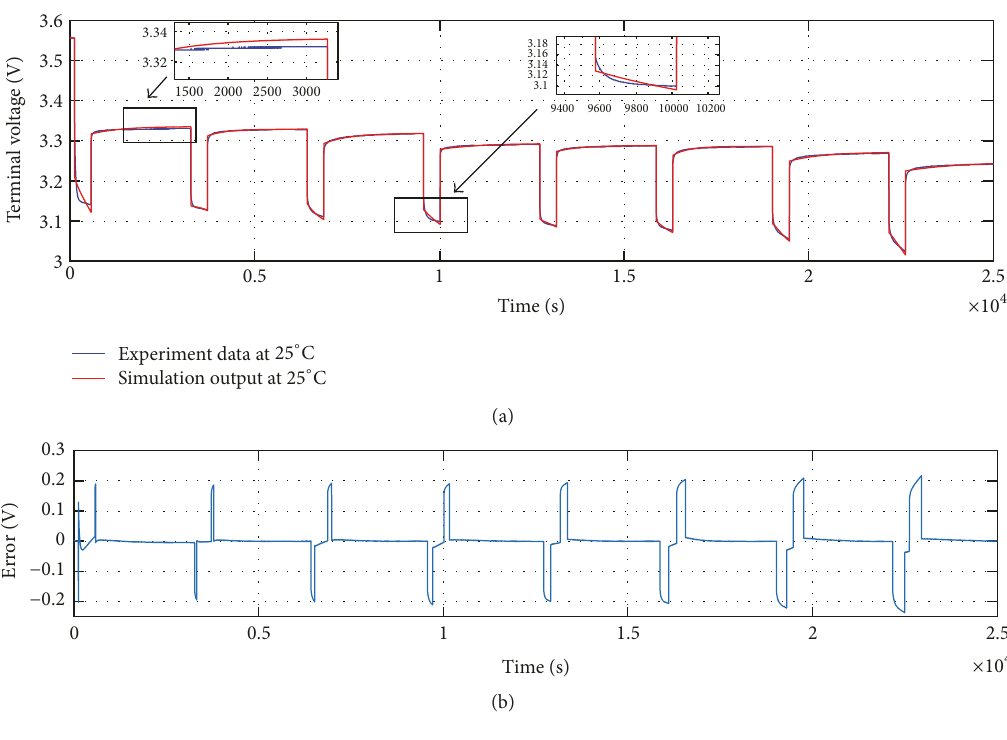
Figure 10: (a) Cell #1 model validated at 25 ∘ C. (b) Cell #1 error between simulation and experiment results at 25 ∘ C.